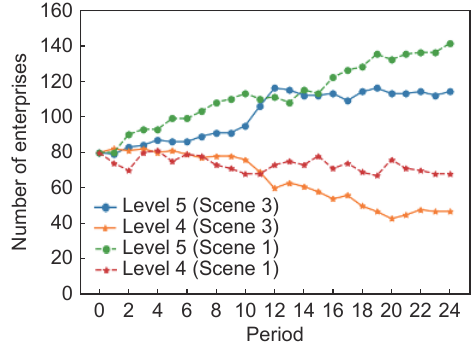
Fig. 8 Scenes 1 and 3: Changes of number of enterprises in Levels 4 and